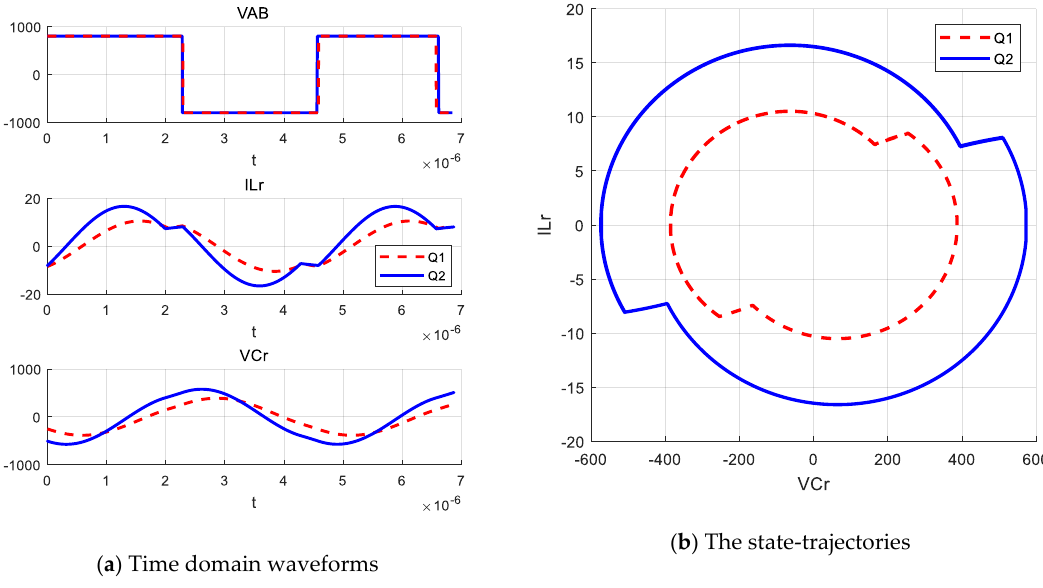
Figure 15. MATLAB calculation results below resonant frequency.